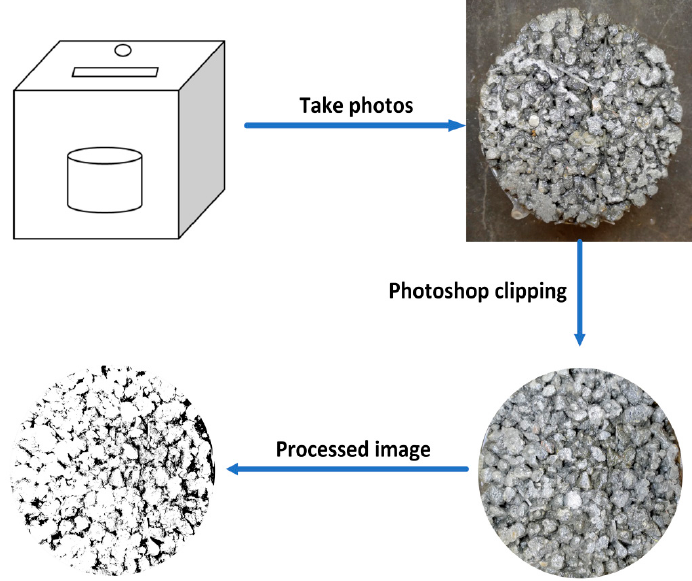
Figure 4. Collection and processing of two-dimensional image of pervious concrete.